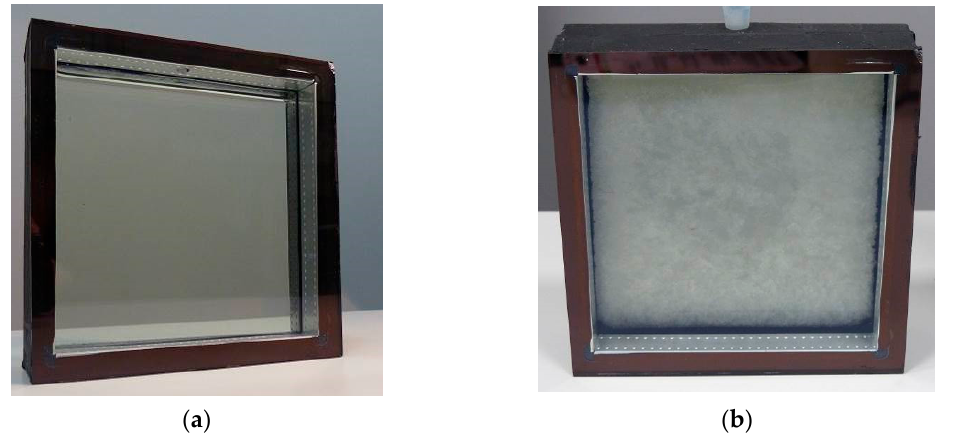
Figure 3. Glass sample prepared for experiment, ( a ) PCM in a liquid state and ( b ) PCM in solid state. The first cavity is empty, the second cavity is filled with PCM.